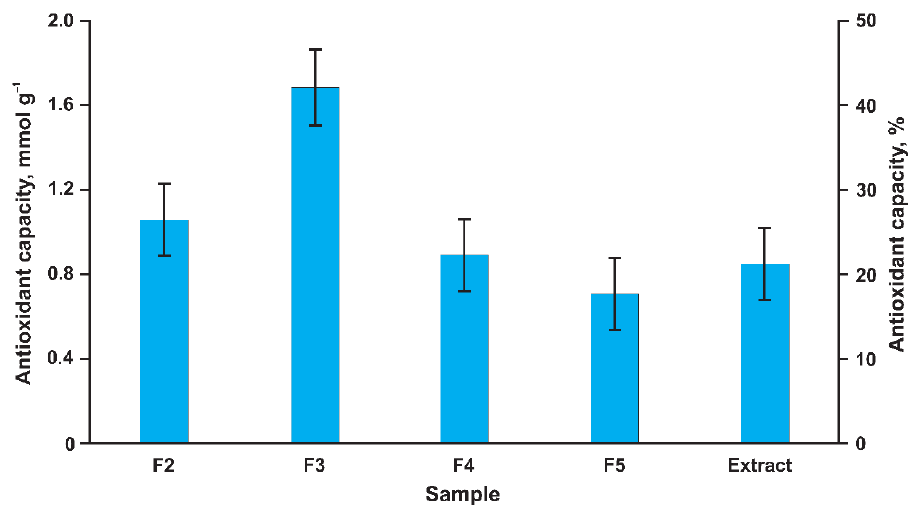
Figure 4. Results of in vitro antioxidant capacity assay by PCL method (in Trolox equivalent).